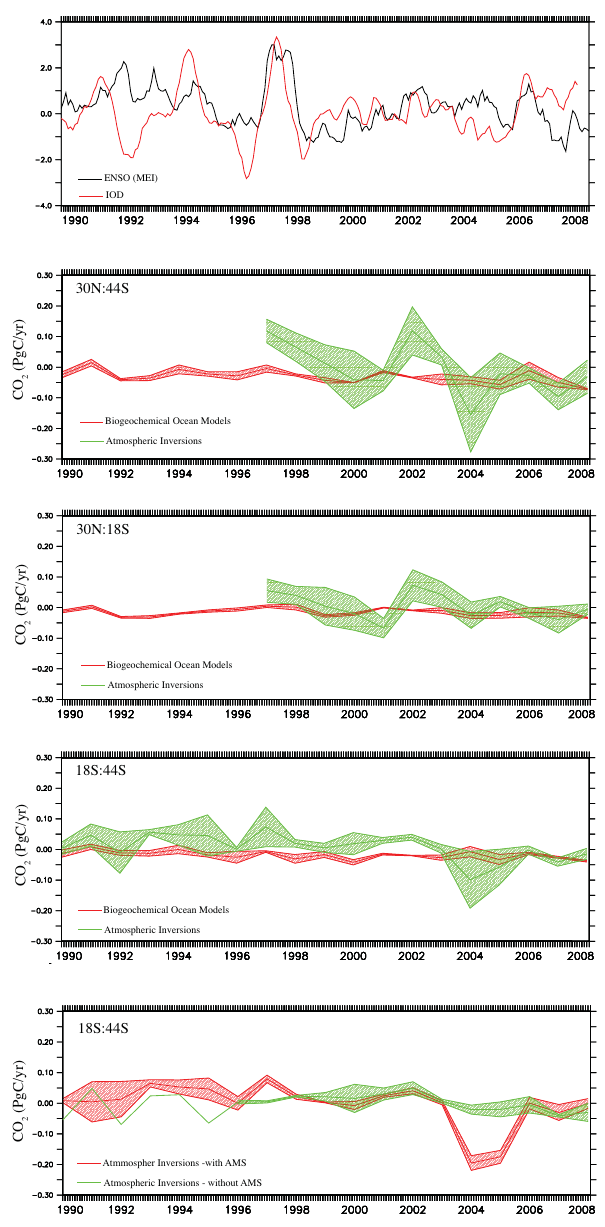
Fig. 11. The oceanic interannual variability from ocean biogeo- chemical models and atmospheric inversions. The upper panel shows ENSO and IOD index (the IOD/IODZM comes from FRCGC based on HADSST; the MEI comes from the ERSL (http://www.esrl.noaa.gov/psd/enso/mei/) that is taken from http: //climexp.knmi.nl). The second panel represents the region 30 ◦ N– 44 ◦ S, the third figure is the region 30 ◦ N–18 ◦ S, the fourth figure the region 18–44 ◦ S, and the bottom panel shows the interannual variability from atmospheric inversions in the region 18–44 ◦ S with and without the AMS data (see text for